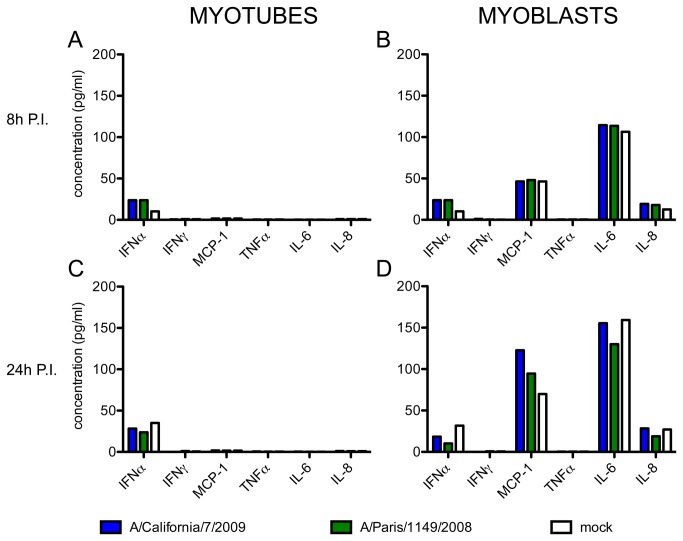
Secretion of 5 cytokines and 1 chemokine by infected muscle cells.The concentrations of IFNα, IFNγ, TNFα, IL-6 and IL‑8 and MCP-1 were simultaneously measured in the culture supernatants of myotubes (left panels) and myoblasts (right panels), at 8h (A, B) and 24h (C, D) after infection with the influenza viruses A/California/7/2009 (blue bars) or A/Paris/1149/2008 (green bars), or in non-infected cells cultured in parallel (white bars). These results are representative of two independent experiments on cells from donor CHQ.